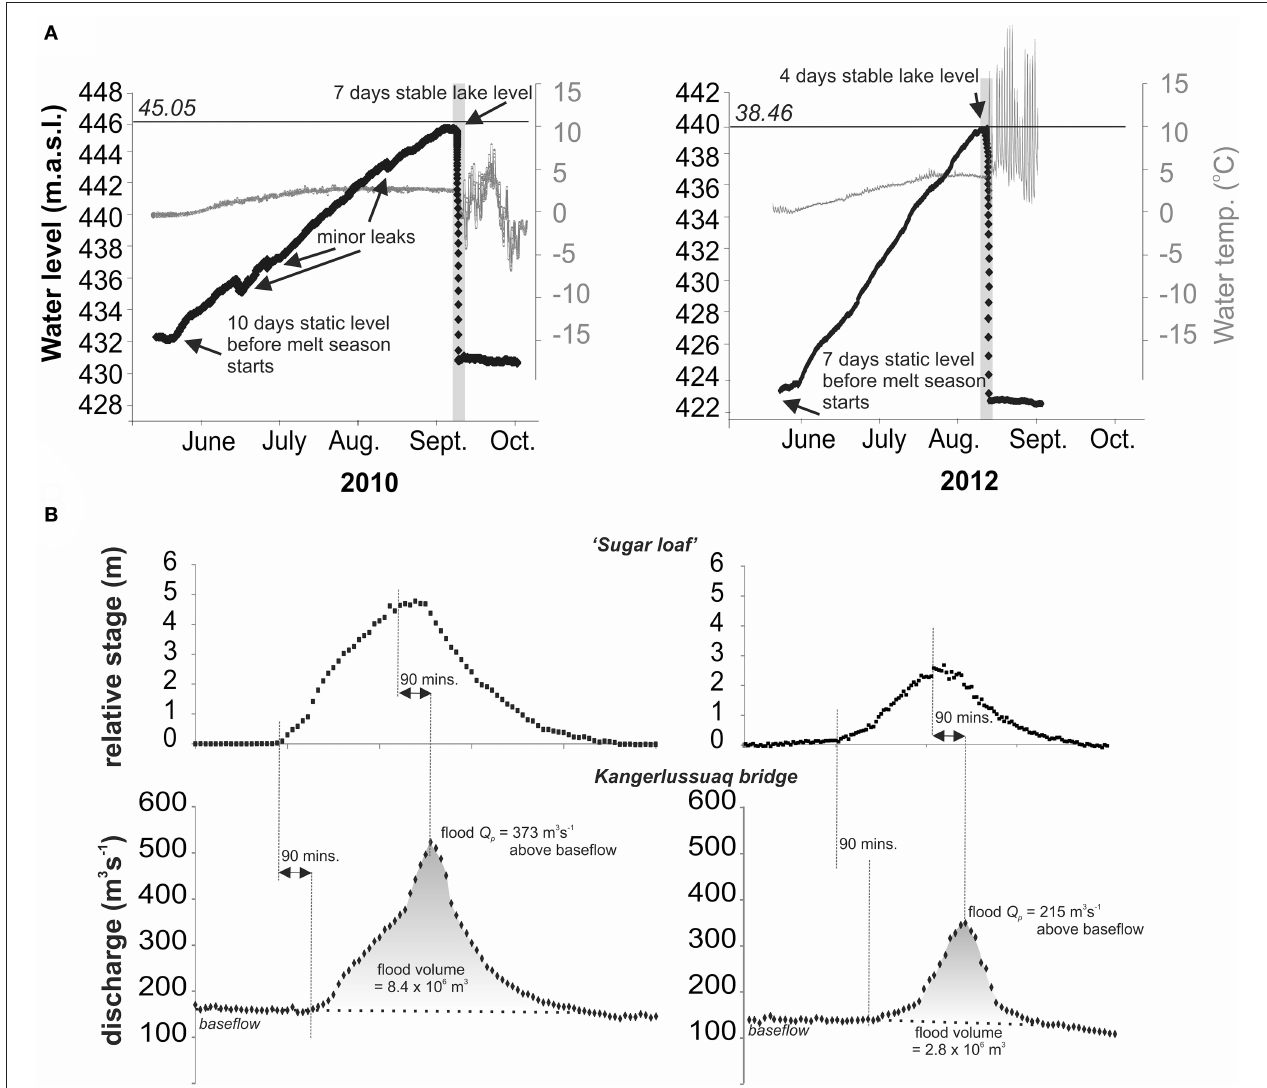
FIGURE 2 | Lake water level and water temperature record for ablation seasons 2010 and 2012 (A) . The gray shaded bars denote the time period depicted in Figures 4A,B . Italicized numbers refer to the maximum thickness of ice that could be liable to flotation given the water level and thus water depth and hydrostatic pressure in comparison to ice overburden pressure. Note varying y axis scales. Panel (B) depicts gauged hydrographs 32km downstream at Kangerlussuaq bridge, both after data by Hasholt et al. (2013) and Mikkelsen et al.